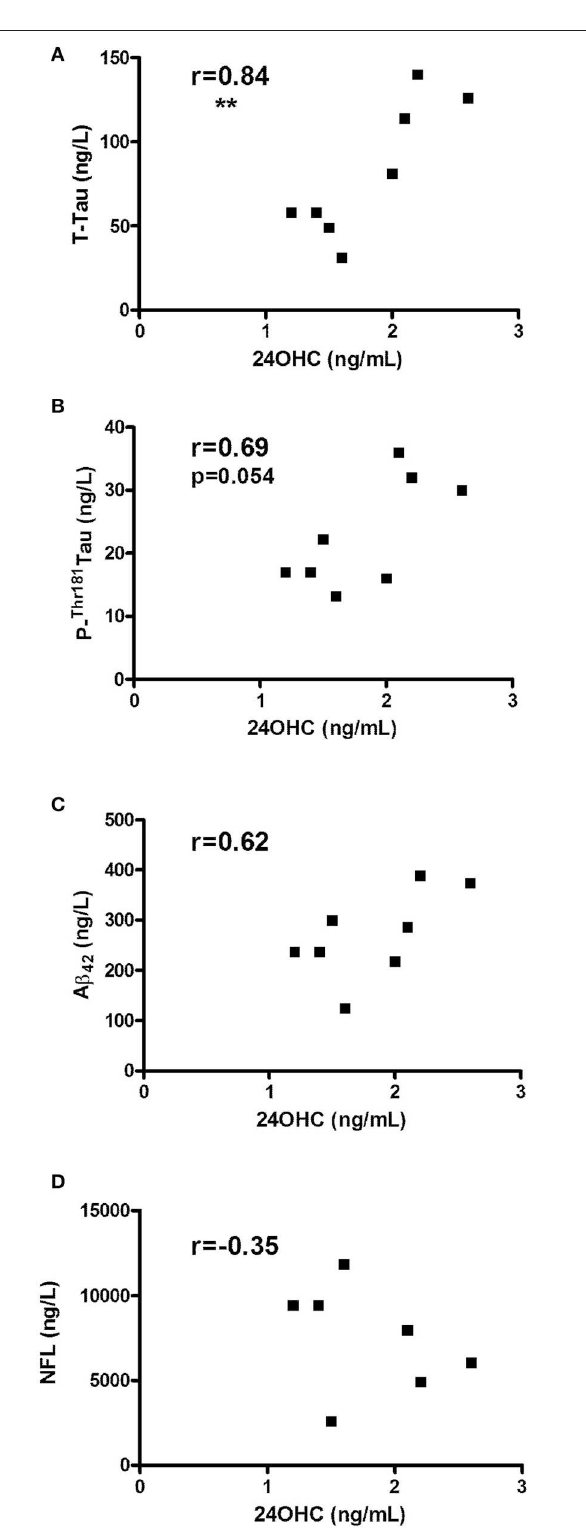
FIGURE 2 | Correlations between CSF levels of 24OHC and total Tau (A) , P-Thr 181 -Tau (B) ,A β 42 (C) orNFL (D) inpatientswithcorticobasaldegeneration (CBD). r values indicate Pearson correlation and ** p < 0.01